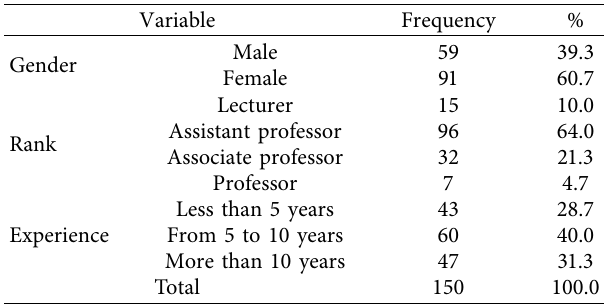
Table 1: Participants and their distribution based on gender, rank, and